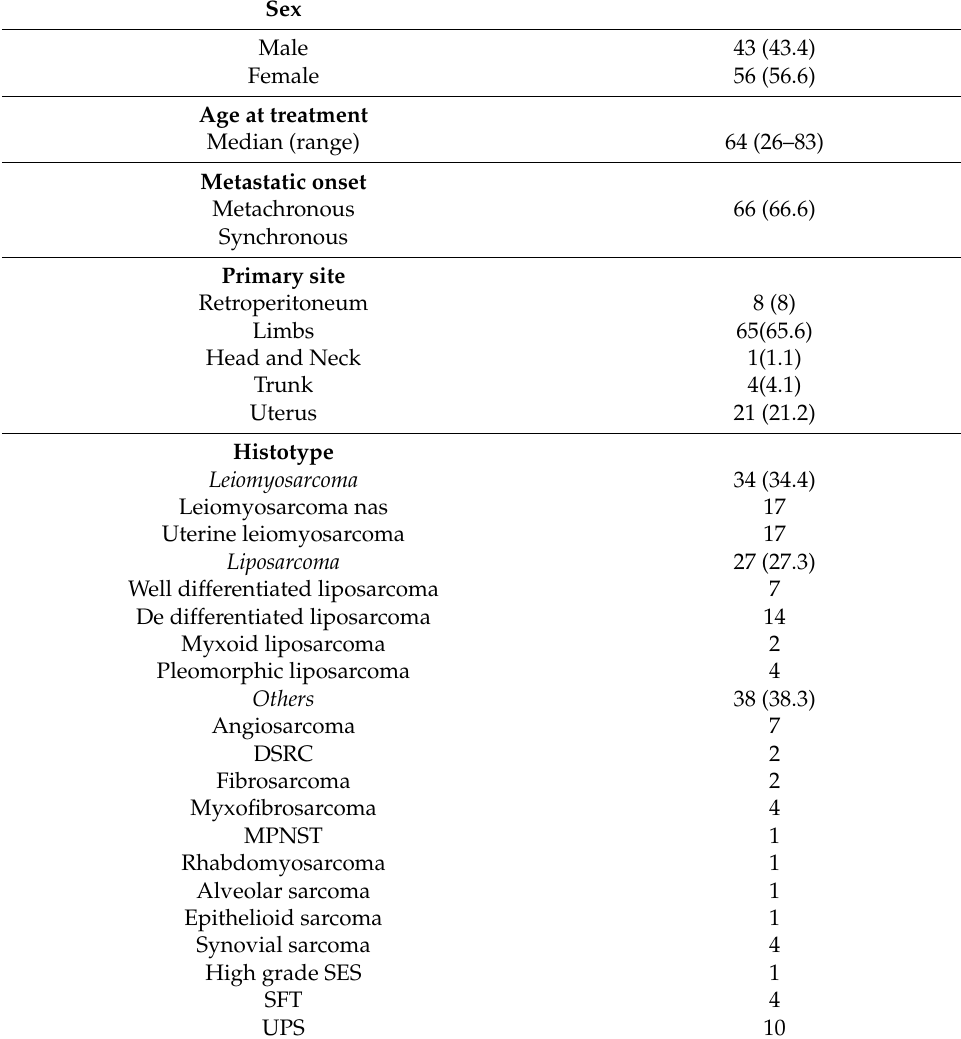
Table 1. Patients’